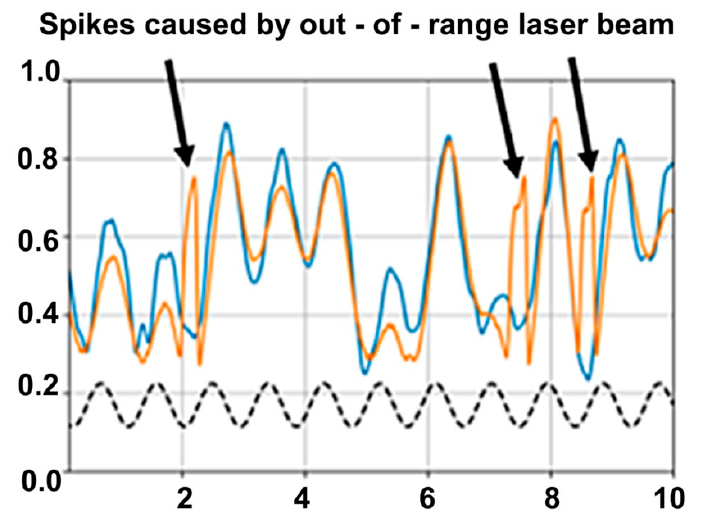
Figure 5. Details of MEMS mirror’s motion while driven at 1100.0 Hz (dash—20 V/div) are recorded by the 4MAPM y -axis differential output signal (blue—200 mV/div) and by the y -axis signal from the PSD (orange—2.3 V/div). To simplify comparison, the 4MAPM signal is phase-shifted to best match the PSD. The two recorded signals match well except where the laser beam position overshoots the PSD range, leading to anomalous spikes in the PSD signal (arrows).